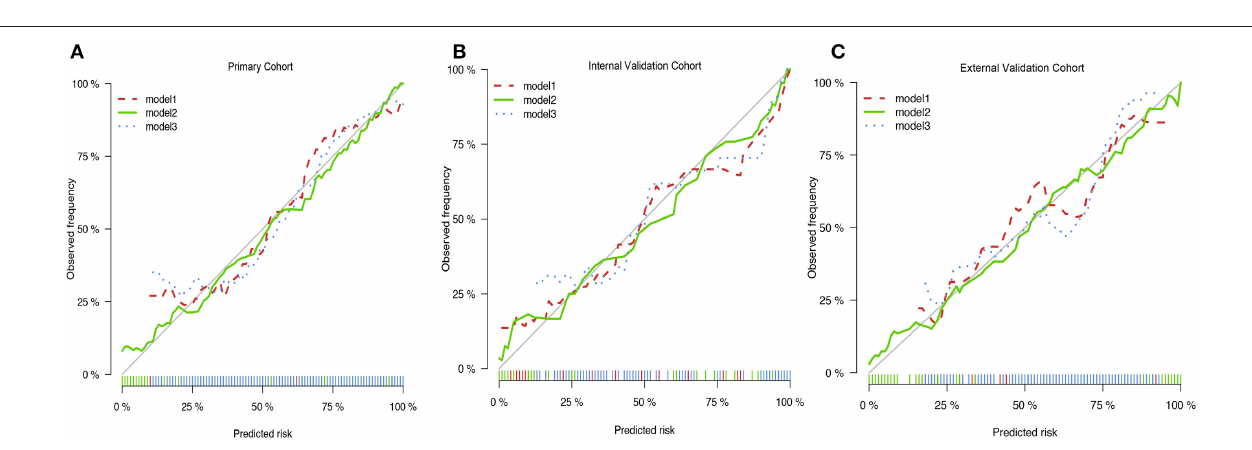
FIGURE 3 | The Calibration curves of three prediction models. (A) The Calibration curves of three prediction models in primary cohort. (B) The Calibration curves of three prediction models in internal validation cohort. (C) The Calibration curves of three prediction models in primary cohort in external